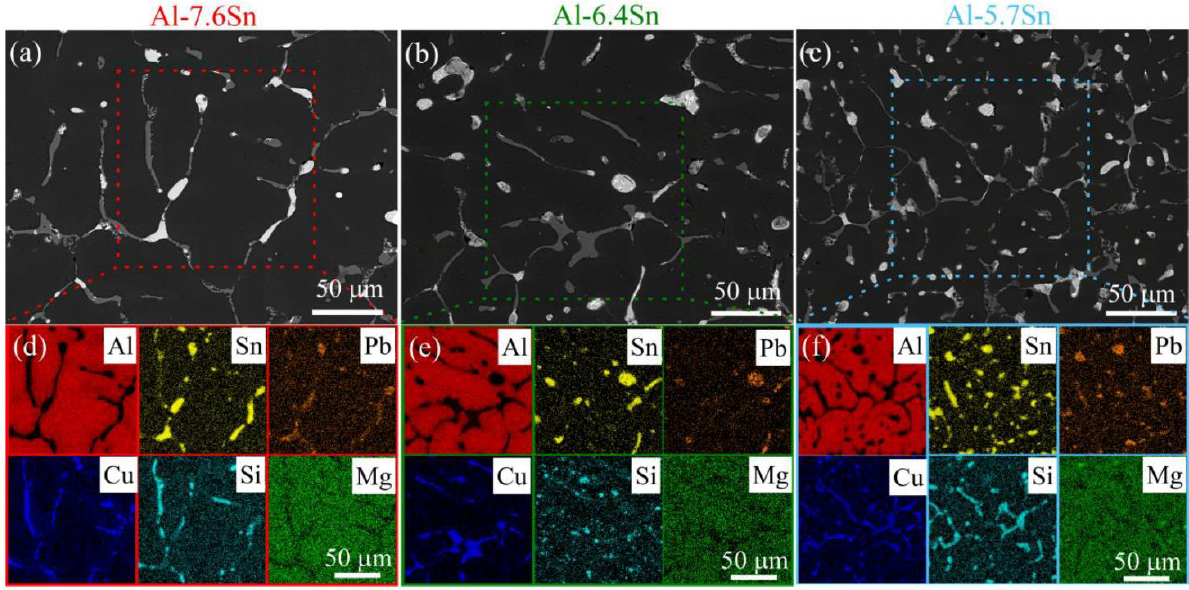
Figure 4. The SEM-BSE microstructures ( a – c ) and corresponding EDS-maps ( d – f ) of the investigated alloys: ( a , d ) Al-7.6Sn, ( b , e ) Al-6.4Sn and ( c , f ) Al-5.7Sn. The Al-6.4Sn and Al-5.7Sn alloys exhibit a similar microstructure to Al-7.6Sn alloy: a dendritic cell structure with a size ranging from 15–115 µ m for Al-6.4Sn alloy and 10–75 µ m for Al-5.7Sn alloy (Figure 4b,c). The element distribution maps (Figure 4e,f) also indicate the presence of the Al-solid solution, the soft structural inclusions of Sn-and Pb-rich phases (Sn- rich, Sn-Pb, and Pb-Sn phases), the solid phases inclusions of Al and Cu-rich phase (Al 2 Cu) and a small fraction of the (Si) phase. The presence of these phases was confirmed by XRD- analysis (Figure 6). The soft and solid phase inclusions have a shape and distribution similar to the Al-7.6Sn alloy. For both alloys, the predominant structure of the soft inclusions is the globular shape ranging in size from 3 to 15 µ m. In addition, there are a small number of elongated inclusions with a thickness of 2–4 µ m and 3–5 µ m and a length ranging from 9 to 41 µ m and from 10 to 18 µ m for the Al-6.4Sn alloy and the Al-5.7Sn alloy, respectively. The solid inclusions of the Al 2 Cu phase are mainly located along the dendritic cell boundaries and have an elongated shape (the thickness ranged from 2 to 5 µ m for the Al-6.4Sn alloy and from 2 to 4 µ m for the Al-5.7 alloy, respectively). The length of the solid phases usually does not exceed 50 µ m for the Al-6.4Sn alloy and 38 µ m for the Al-5.7 alloy. The EDS point analysis of the investigated Al-6.4Sn and Al-5.7Sn alloys (Figure 5c–f) also indicates the presence of the structural components: the Al-solid solution with copper, zinc, and silicon, soft phase inclusions with Sn and Pb (Sn-rich, Sn-Pb, Pb-Sn phases), and